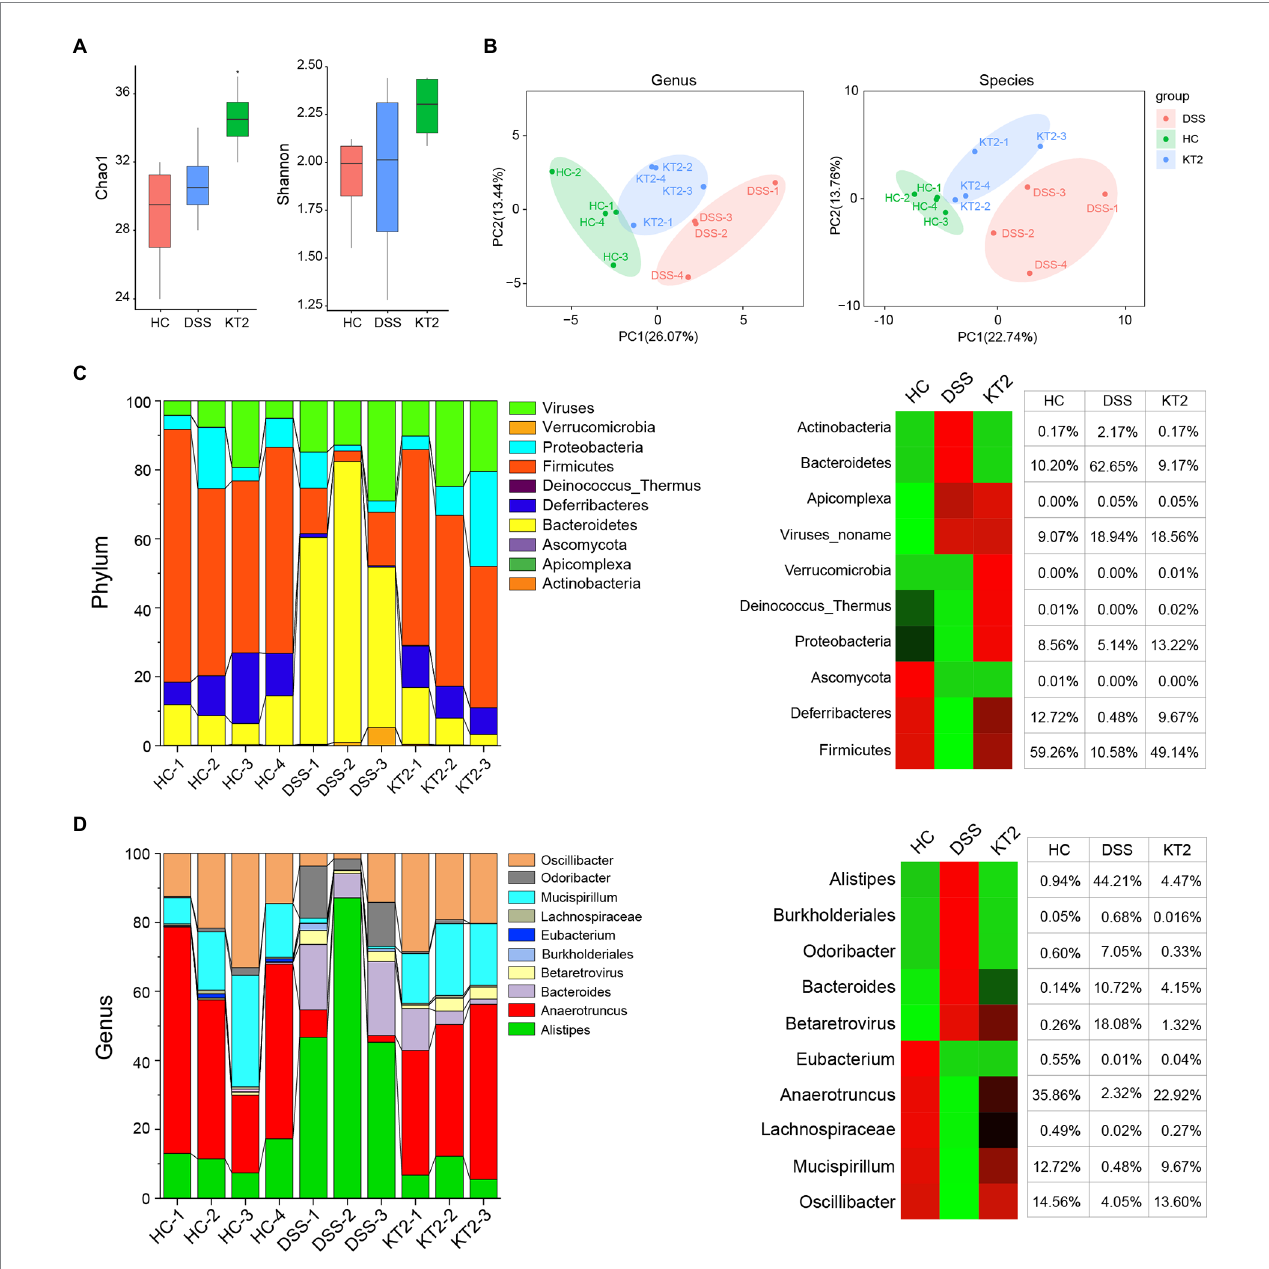
FIGURE 2 R1. Gut microbiome diversity and structural analysis. (A) Species diversity differences in HC, DSS, and KT2 groups, estimated by observed species and Shannon and Chao 1 indices. (B) PCA plot based on relative abundance of species showing bacterial structural clustering. (i) Left panel shows PCA plot between HC and DSS groups, (ii) right panel shows PCA plot between the DSS and KT2 groups. Dots represent individual samples. (C) Component proportion of bacterial phyla in each group (top 10). (D) Component proportion of bacterial genera in each group (top